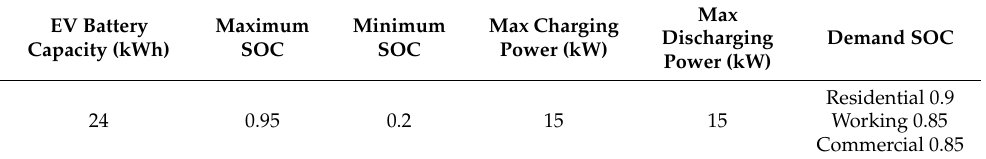
Table 2. Parameters of EVs in the model.